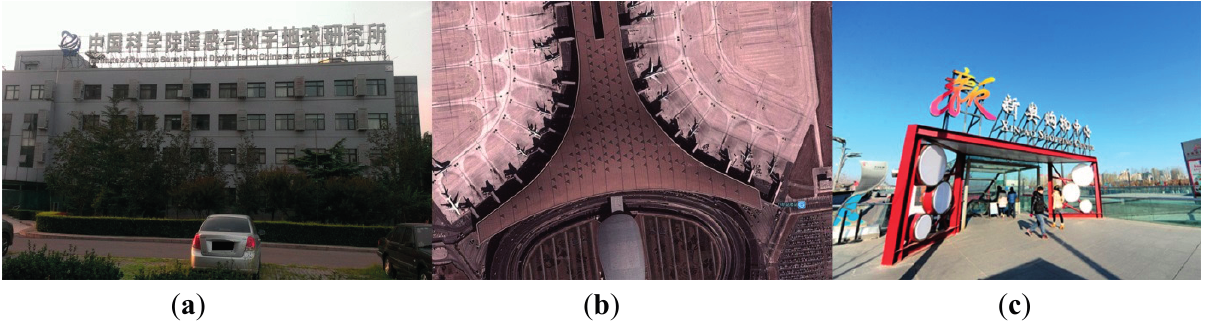
Figure 5. Experimental sites. ( a ) An ordinary office building ( b ) Terminal 3 in